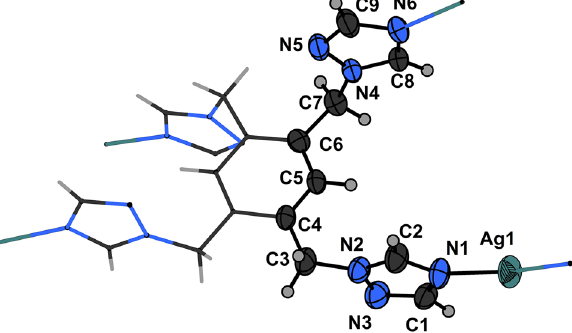
Table 1 contains crystallographic data and Table 2 contains the list of the atoms including atomic coordinates and displacement parameters.